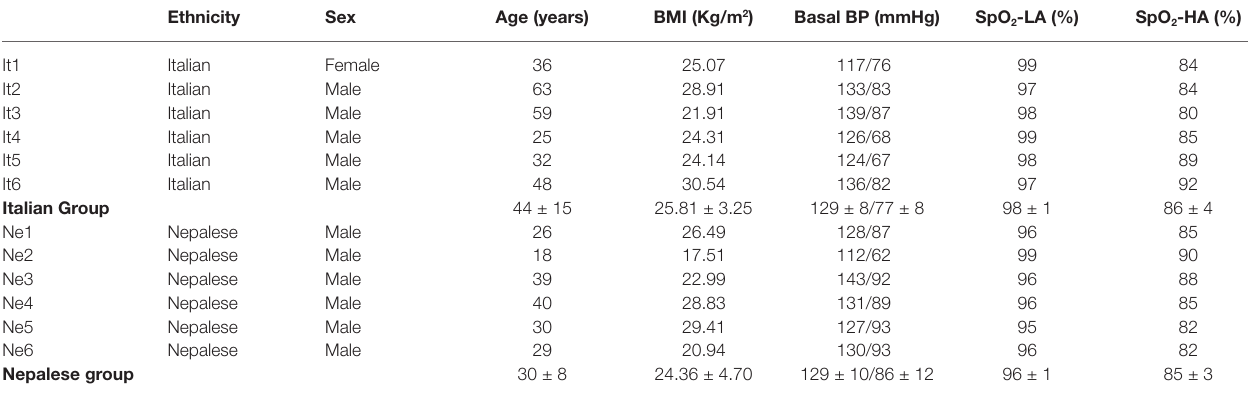
TABLE 1 | Descriptive characteristics of participants and oxygen saturation measured in the same days of NIRS testing; Blood pressure (BP) is expressed as SystolicBP/DiastolicBP; group values are expressed as mean ± SD.